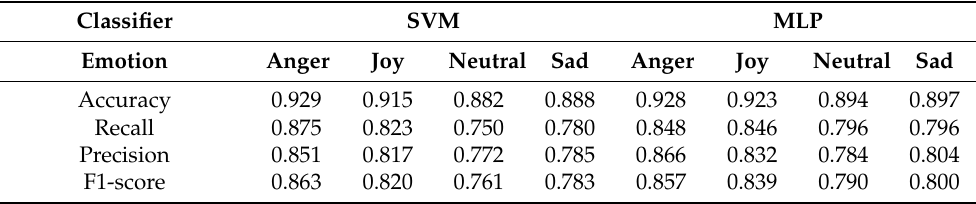
Table 2. Per-class scores in multi-class classification, eGeMAPS feature set.